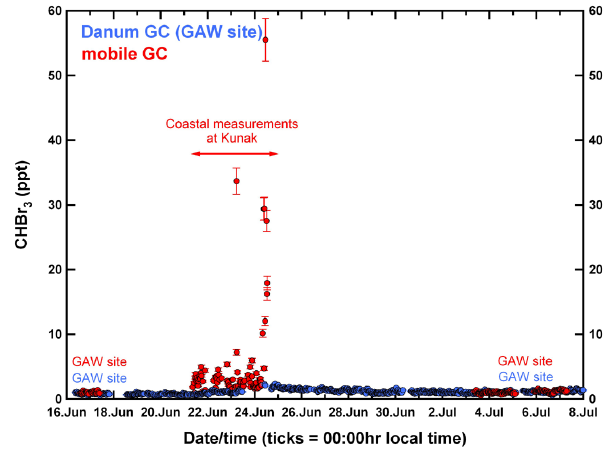
Fig. 1. Concentration of CHBr 3 (ppt) measured at Danum Valley and Kunak by the µ -Dirac GC. Blue symbols indicate measure- ments with the instrument deployed throughout at Danum Valley. Red symbols are concentrations measured by the instrument which was deployed at Kunak between 21 and 25 June, but otherwise was at Danum